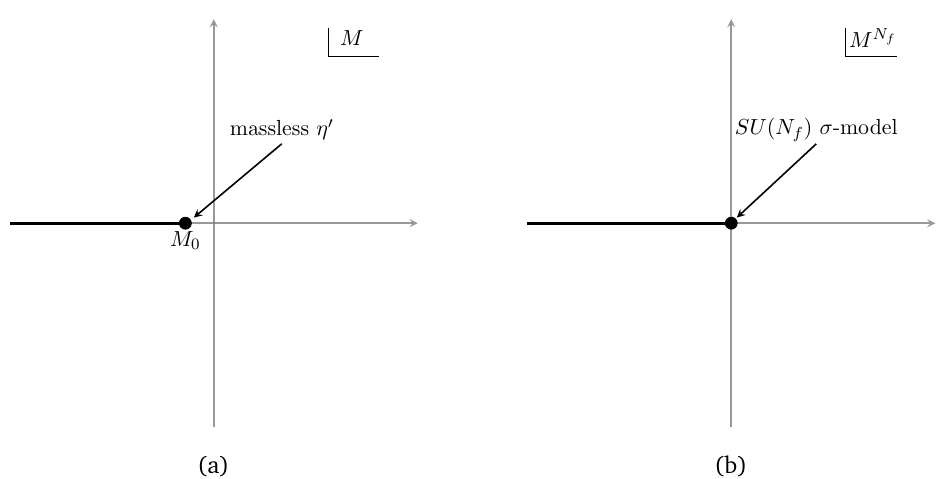
Figure 1: (a) The phase diagram of QCD with single quark. The first order line terminates at M = M with a massless η (cid:48) particle. (b) The phase diagram of QCD 0 > N > 1 quarks. The first order line terminates at M = 0 with an SU ( N with N f CFT non-linear sigma